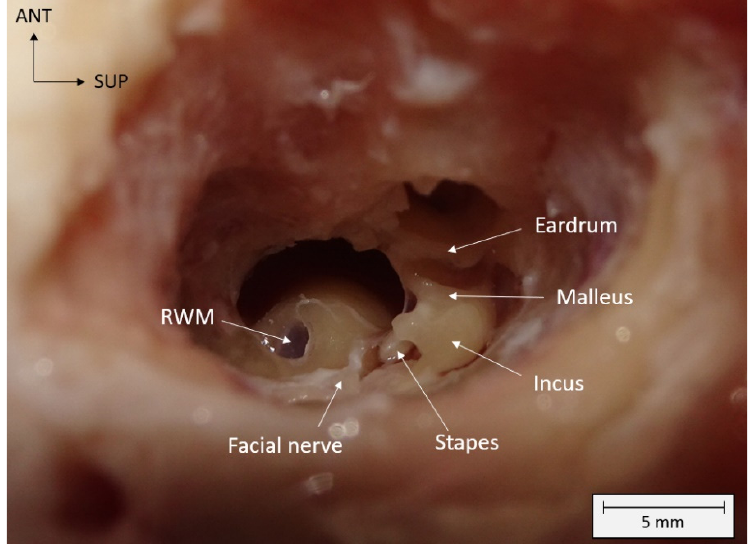
Figure 2. Visualization of the round window membrane (RWM) and anatomical structures of the middle ear after mastoidectomy on a left ewe ear. Spatial orientation is shown with anterior (ANT) and superior (SUP) localizations. mm: millimeters.